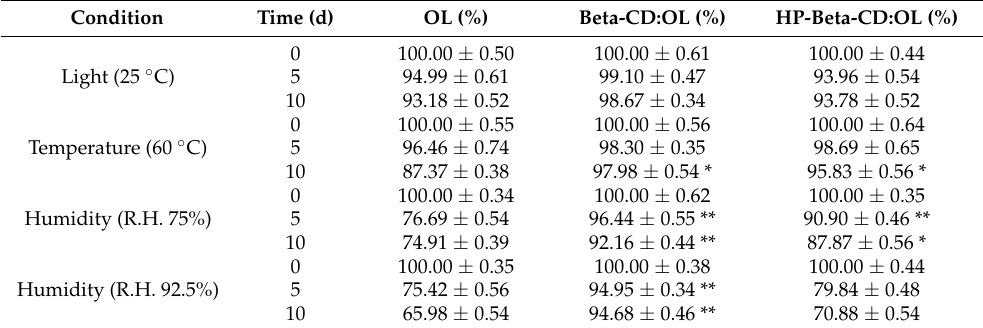
Table 3. The effects of light, temperature, and humidity on the stability of OL and its inclusion complexes.